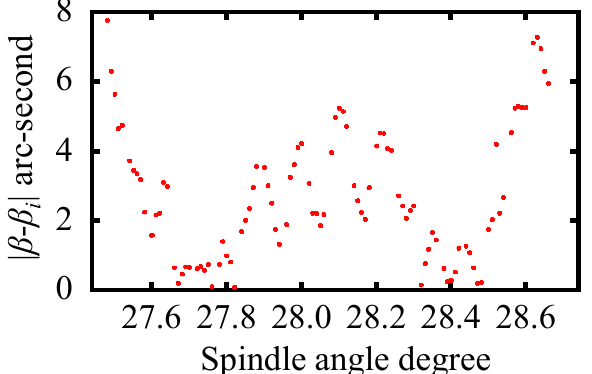
Figure 13. The deviation of β i from β . (c) Uncertainty of the detection of the angle θ i of the i th-mode positive or negative first-order diffracted beam ( u ( θ i ))